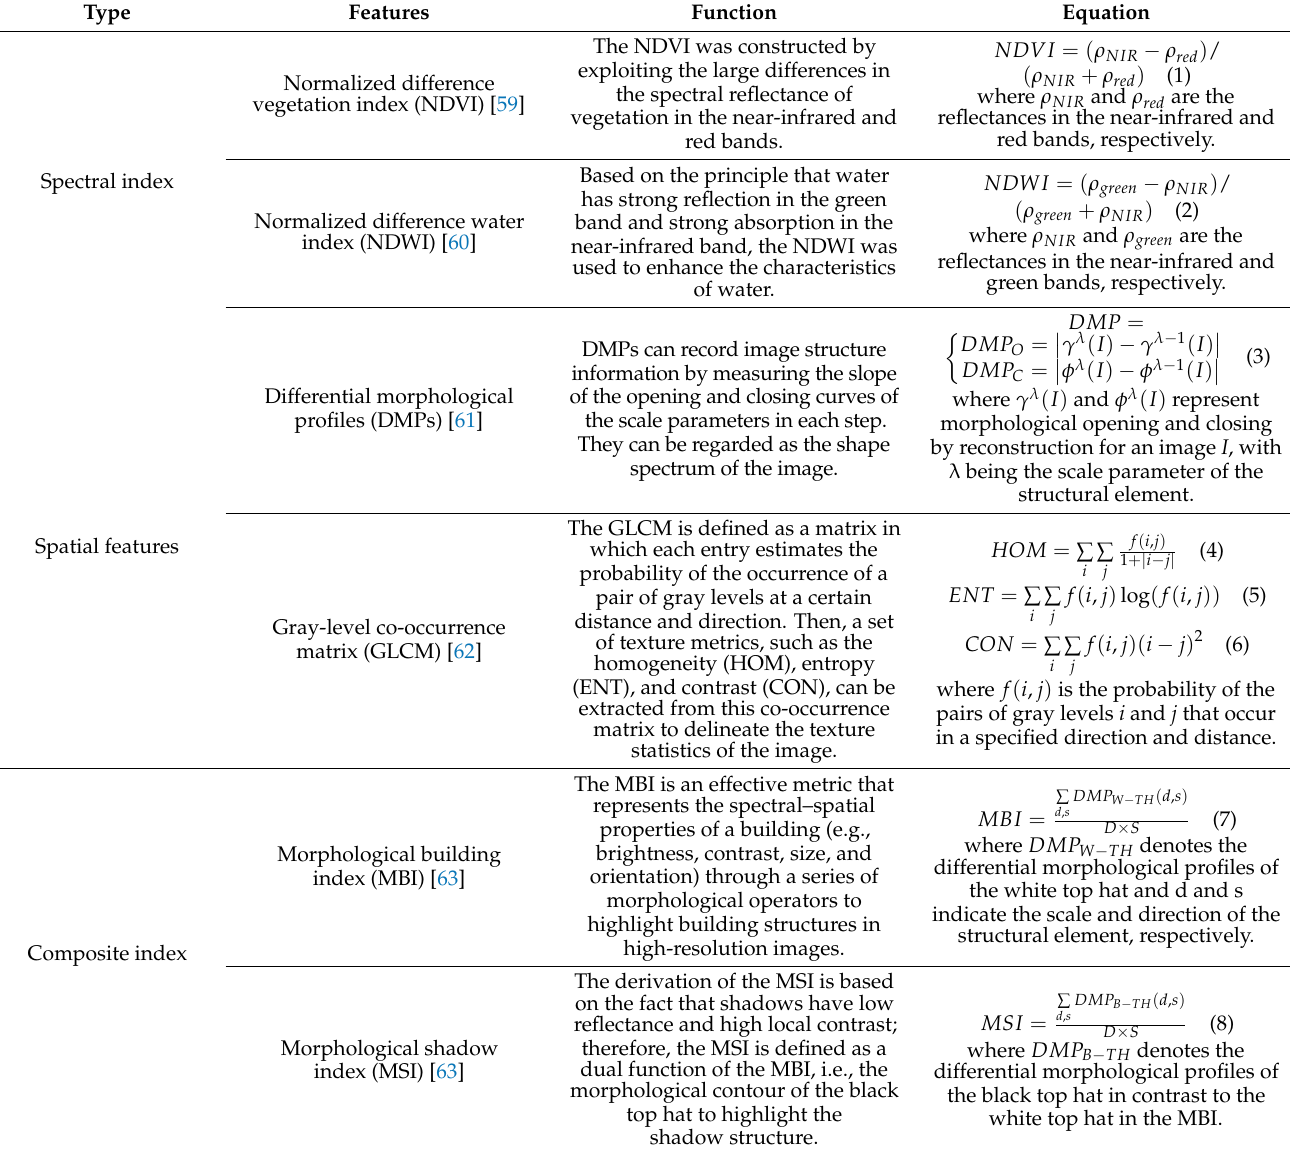
Table 2. Multiple features considered in this